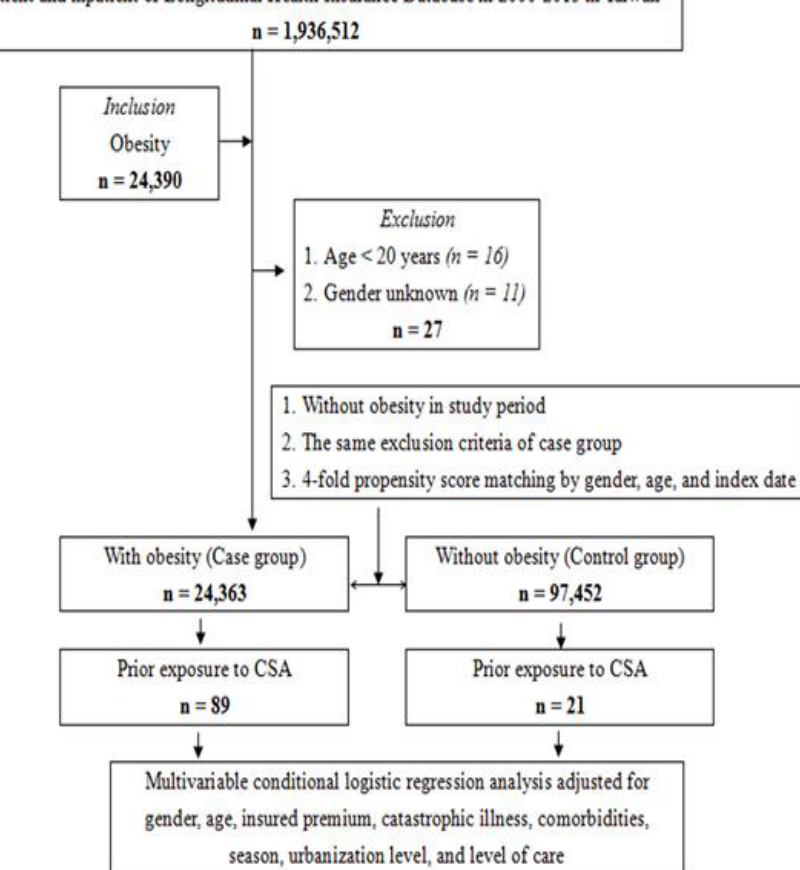
Figure 1. The flowchart of the study design from National Health Insurance Research Database in Taiwan.